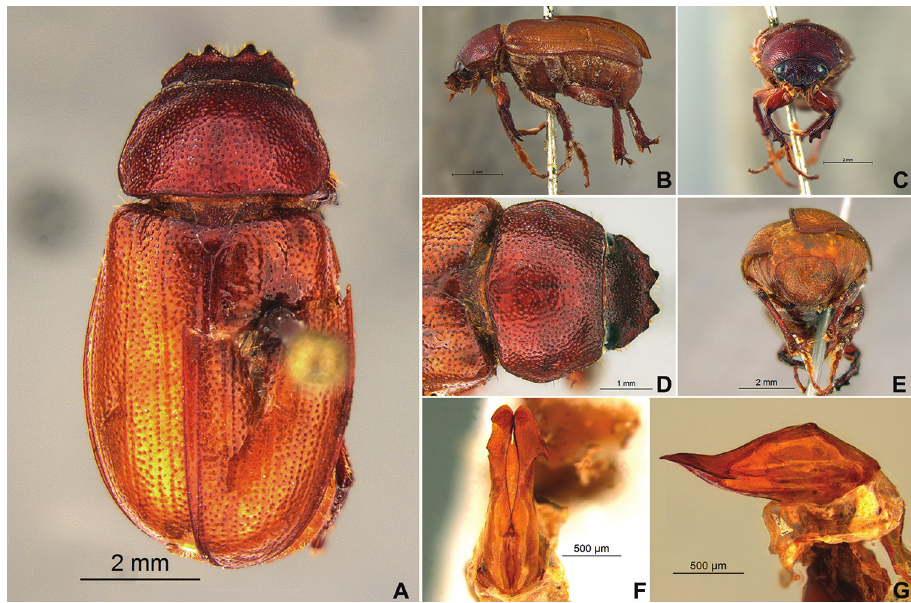
Figure 68. Liogenys parva Blanchard. A Dorsal view B Lateral view C Frontal view D Clypeus and pronotum E Pygidium F Parameres, dorsal view G Parameres, lateral view. Redescription. Length: 8.0–9.0 mm; width: 4.4 mm. Yellowish brown. Head